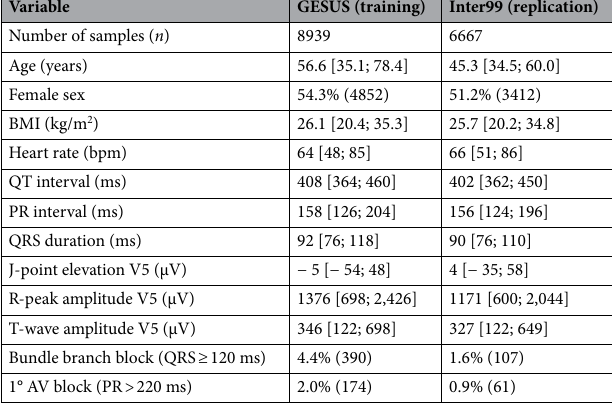
Table 1. Characteristics of the participants in both population studies. Values are presented as median [fifth to ninety-fifth percentiles] for continuous measures and % ( n ) for categorical variables.